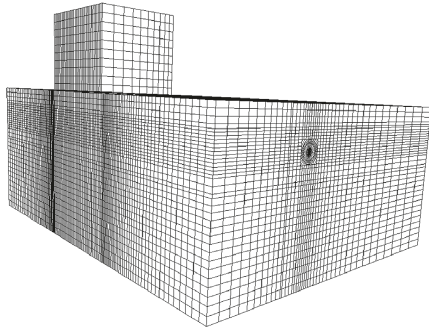
Figure 7: Meshing of the model grid unit.